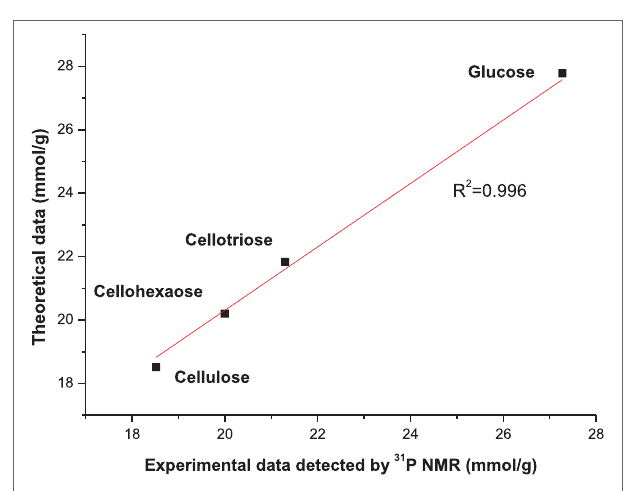
FigUre 4 | The correlation between experimental and theoretical data of hydroxyl group contents of cellulose and cellulose model compounds.